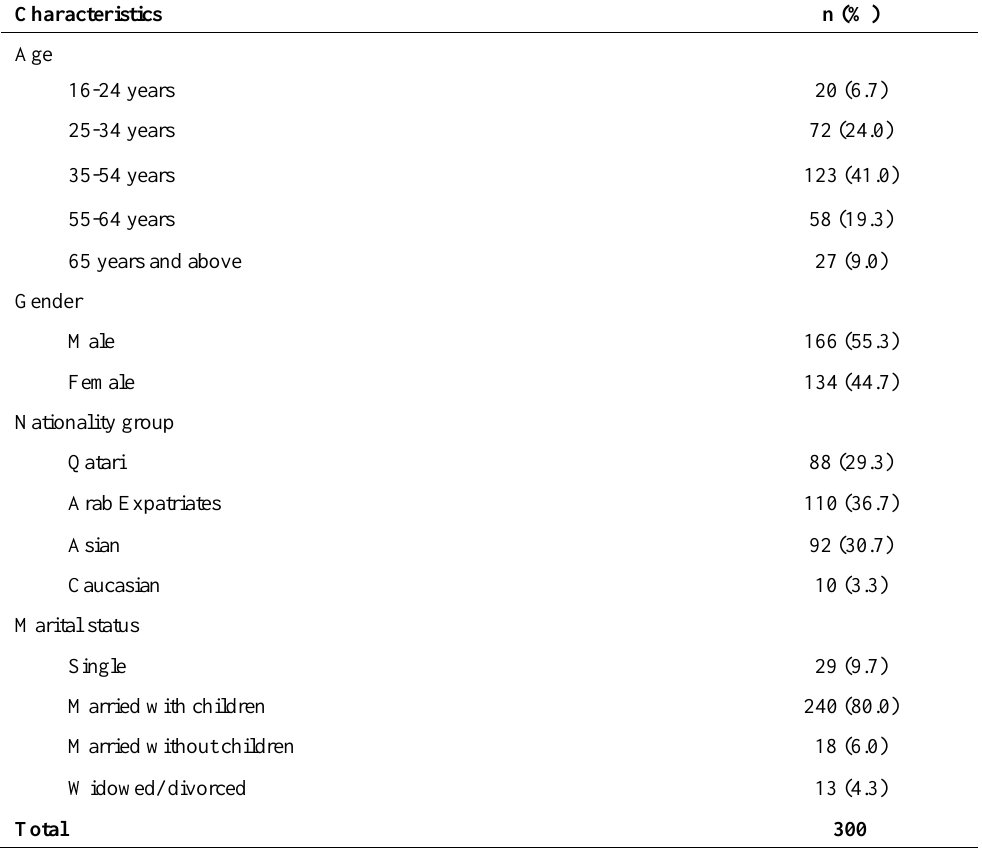
Table 1 . Demographic characteristics of the